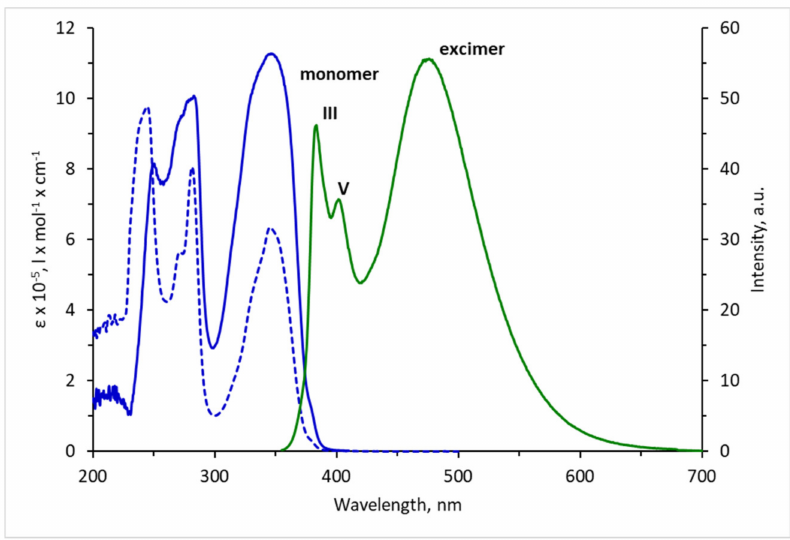
Figure 4. Absorption (–), excitation (–), and emission (–) spectra of P4 in